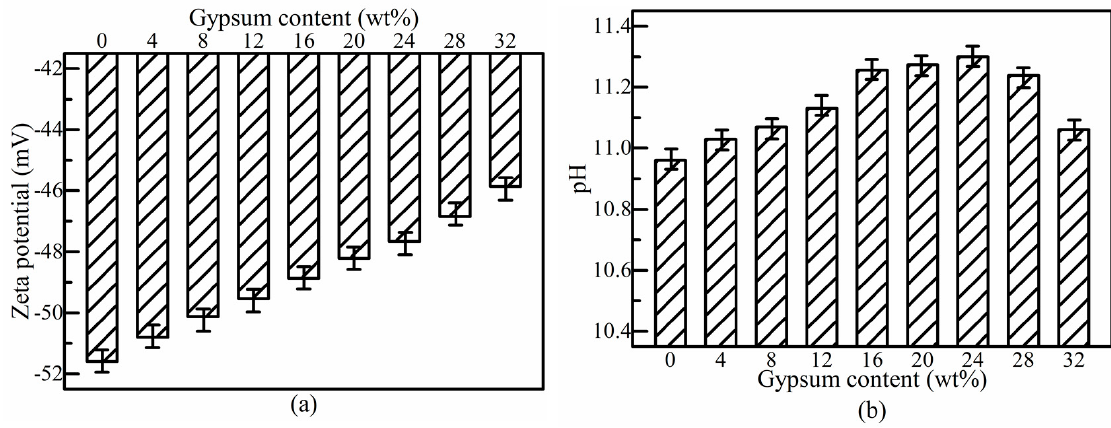
Figure 13. ( a ) Zeta potential and ( b ) pH value for fresh SSB-CPB with di ff erent DG dosages.